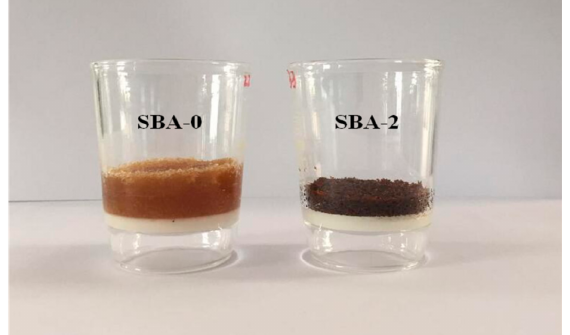
Figure 6. Sol–gel test of cured